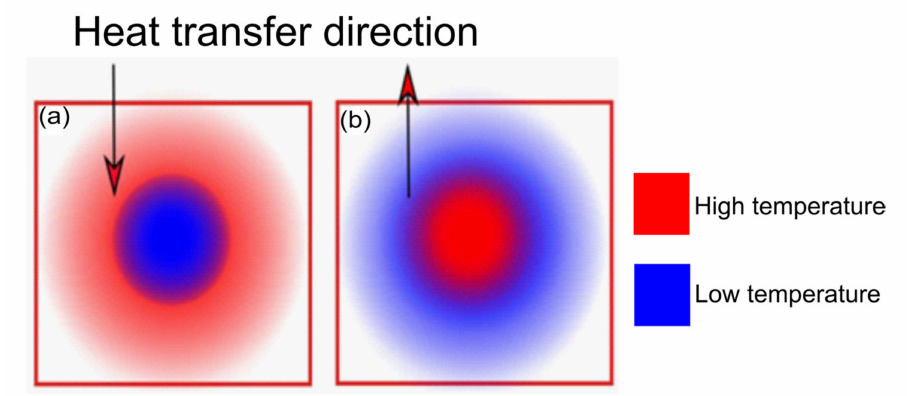
Figure 1. - Schematic diagram of temperature distribution, in the ( a ) conventional pyrolysis and HTC and ( b ) microwave